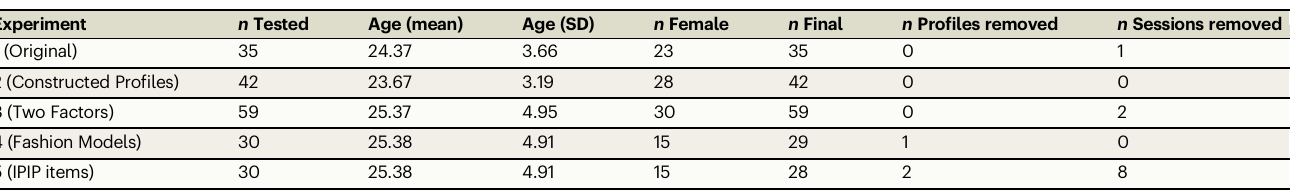
Table 2 | Overview of the participants for the fi ve experiments